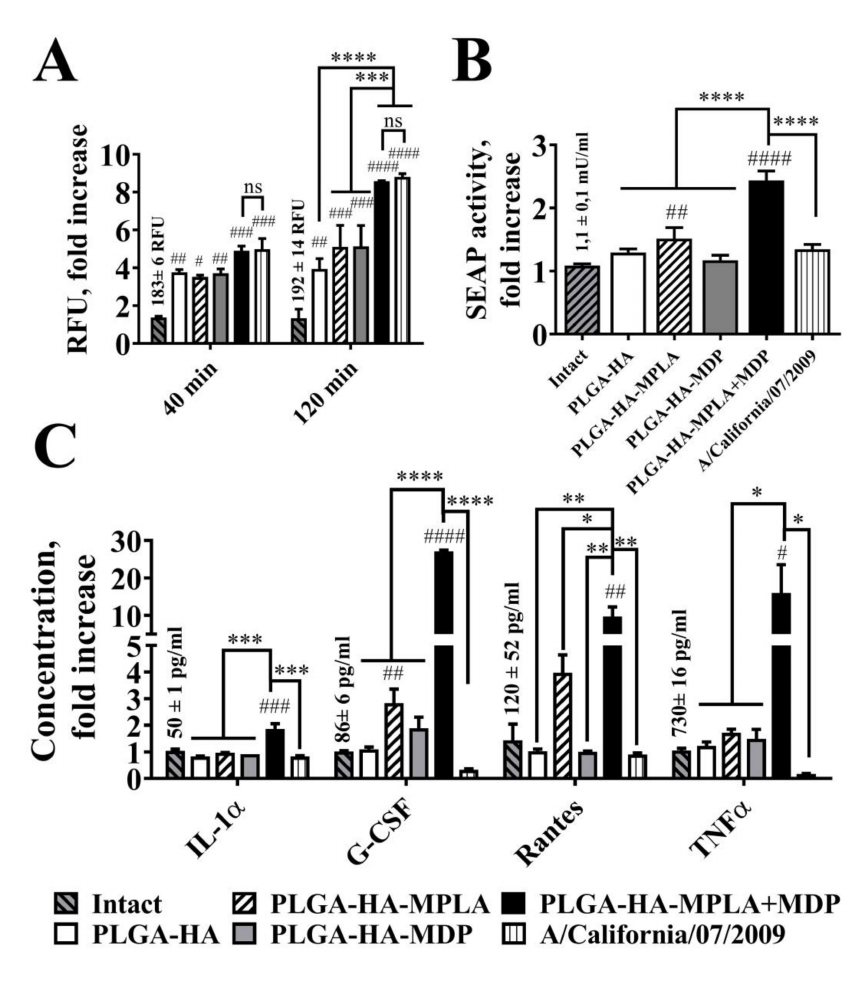
Figure 3. Phagocytosis rate and cell response after the addition of equal amounts of PLGA NPs and H1N1 influenza viral particles to RAW-Blue cells. ( A ) Phagocytosis quantification of PLGA NPs and H1N1 influenza viral particles. RAW-Blue cells were seeded in 96-well plate at 2 × 10 5 cells per well in complete RPMI medium. The next day, normalized to 10 10 particles / well PLGA (roughly equal to 100 µ g / ml) and virus particles were added to the cells. The medium was removed at the indicated time points, the cells were washed with PBS, and the integral fluorescence (RFU) of each well was determined using a Biotek reader. Mean values (indicated above the bars) of intact cells were taken equal to 1 (100%). Data represent the mean ( n = 3) fold increase over intact cells ± SD. ( B ) NF- κ B / AP-1-dependent SEAP reporter gene expression in cell-free culture supernatants from RAW-Blue cells treated for 18 h with PLGA and with virus particles normalized by quantity (10 10 particles / well). Mean values (indicated above the bars) of intact cells were taken equal to 1 (100%). Data represent the mean ( n = 3) fold increase over intact cells ± SD. ( C ) Cytokine levels were measured in cell-free culture supernatants from the same wells using bead-based immunoassay. Bars represent mean fold increase ± SD (whiskers) over intact group. Values (mean concentrations ± SD are indicated above the bars) of intact groups were taken equal to 1 (100%). Significant di ff erences between treated and intact cells are indicated by hashes: # for p < 0.05, ## for p < 0.01, ### for p < 0.001, or #### for p < 0.0001. Statistically significant di ff erences are shown among groups as indicated by asterisks and brackets: * for p < 0.05, ** for p < 0.01, *** for p < 0.001, or **** for p < 0.0001. p -values were calculated using two-way ANOVA post-hoc Tukey’s test ( A ) and one-way ANOVA post-hoc Tukey’s test ( B , C